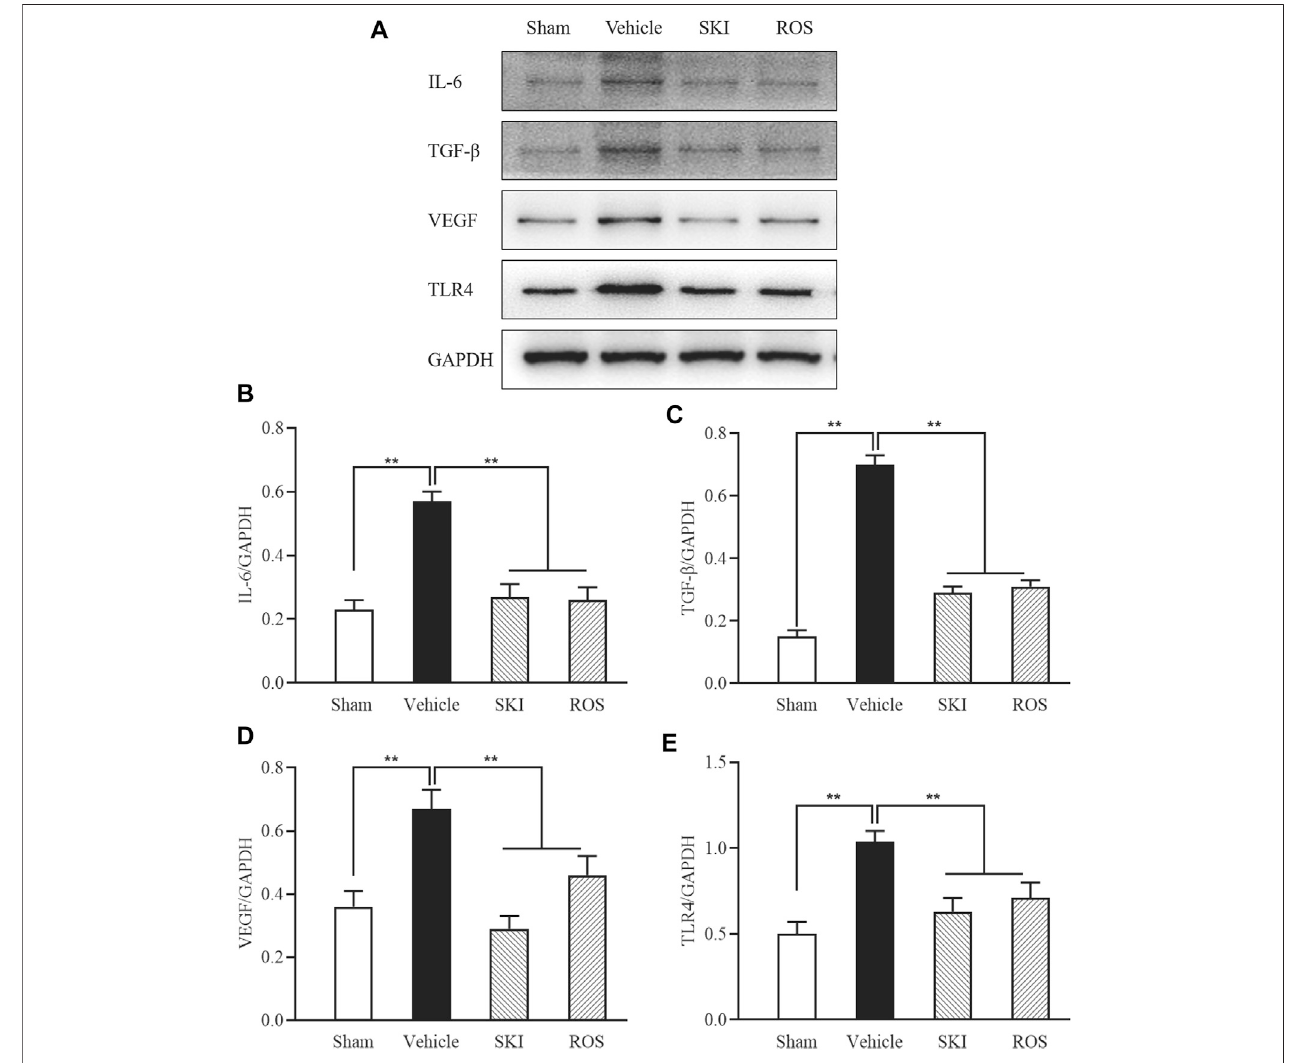
FIGURE5| Theeffects ofSKIand ROSonthe protein expression levels ofIL-6, TGF- β ,VEGF,and TLR4, invivo . (A) WB analysisofIL-6,TGF- β , VEGF,and TLR4, in the kidney; (B – E) The rate of IL-6, TGF- β , VEGF, and TLR4 to GAPDH, respectively. Data are expressed as mean ± S.E. ** p < 0.01. Abbreviations: IL-6, interleukin-6; TGF- β , transforming growth factor- β ; VEGF, vascular endothelial growth factor; TLR4, till-like receptor 4; GAPDH, glyceraldehyde-3-phosphate dehydrogenase; ROS, rosiglitazone; SKI, Shenkang injection.